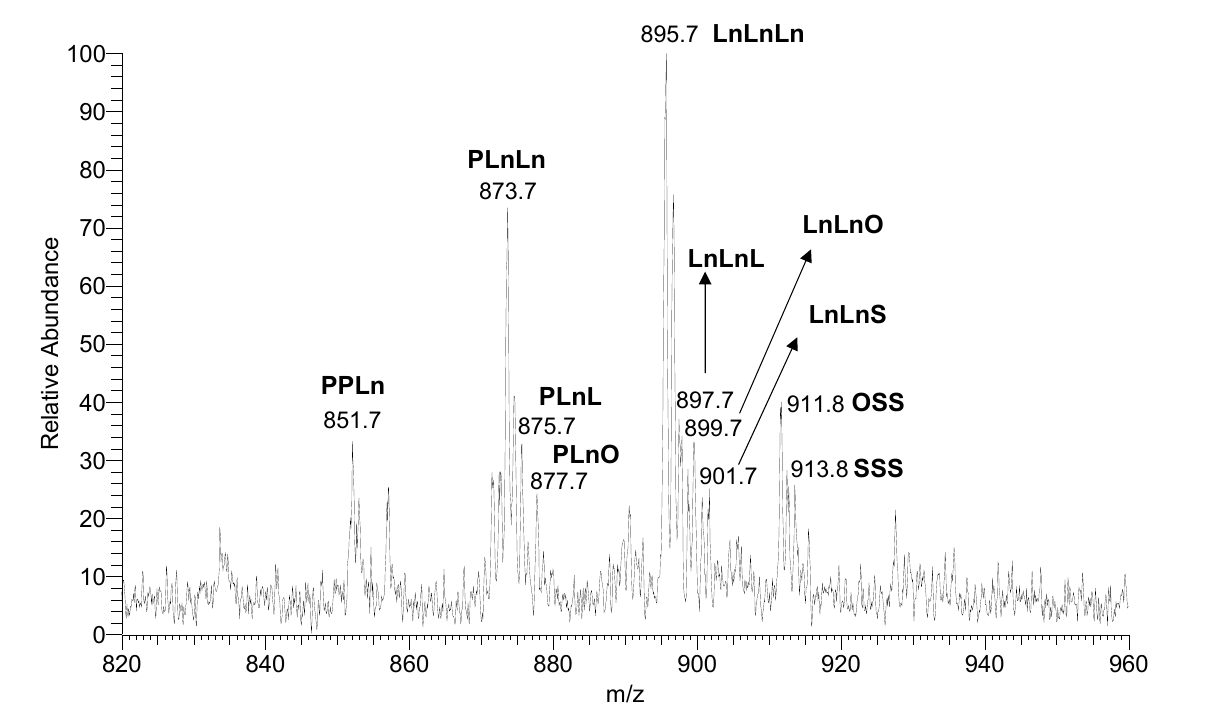
Figure 1. Amplification of the TAG region in the 820-960 mass range of the AP-MALDI mass spectrum. Considering the prevalent fatty acids found in the pomegranate oil [27], the ionic peaks identified in the mass spectrum may correspond to PLnLn ( m/z = 873.7), PLnL ( m/z = 875.7), LnLnLn ( m/z = 895.7), LnLnL ( m/z = 897.5), OSS ( m/z = 911.8), and SSS ( m/z = 913.8). The ions at m/z 899.7 and 901.7 can be associated with different combinations of fatty acid residues (Table S2). In the case of the species at m/z 899.7 two possible compositions